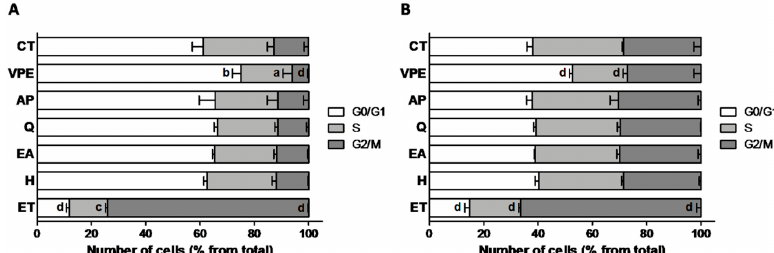
Figure 3. Effect of 48 h exposure to VPE (IC 50 ) and of its major constituents (as present in respective IC 50 – see Table 3) on cell cycle of HCT116 ( A ) and RKO ( B ) cells, as assessed by flow cytometry. Values are expressed as mean ± SEM of three independent experiments. Letters represent statistical significance: a p ≤ 0.05, b p ≤ 0.01, c p ≤ 0.001, d p ≤ 0.0001, when compared with respective phase control by one-way ANOVA.